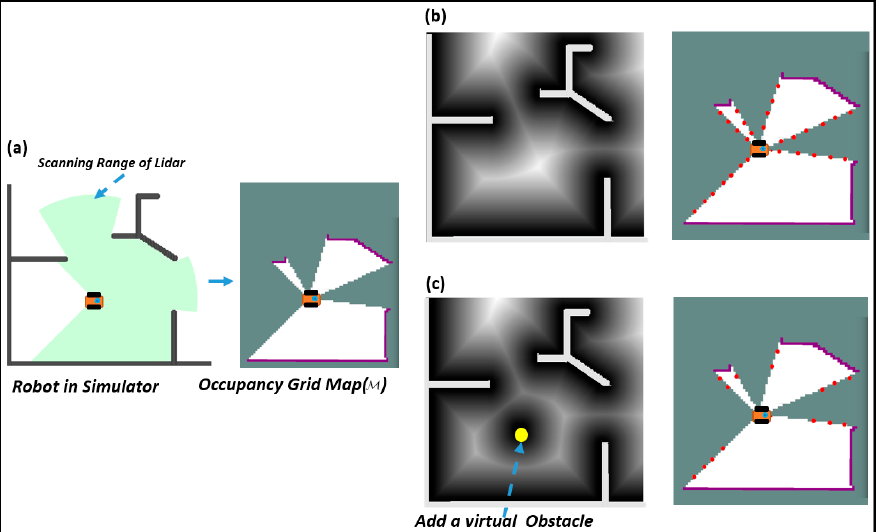
Figure 2. The schematic diagram shows the removal of inefficient frontiers through updating the distance map locally. ( a ) Shows the robot with lidar data and updated M in the simulation environment. ( b ) Shows the actual distance map and the acquired frontiers. ( c ) Shows the change of distance map by adding a virtual obstacle on the robot’s position to remove inefficient frontiers.